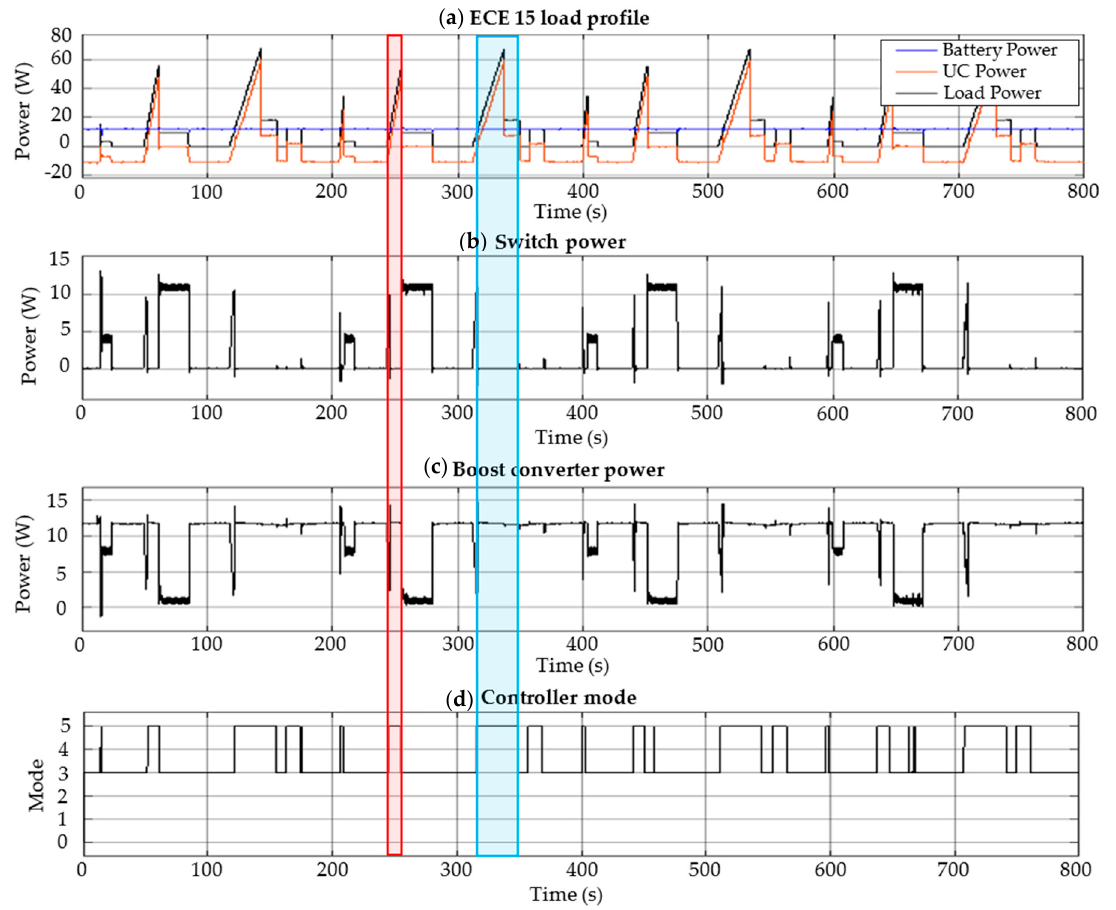
Figure 15. ( a ) ECE 15 power distribution; ( b ) Power through the switch; ( c ) Power transferred through the boost converter; ( d ) Controller operating mode.